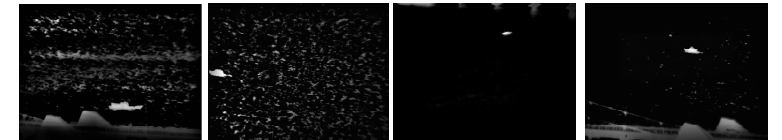
Gaussian Difference Image Local Minimum Image Figure 6. Flowchart of preprocessing algorithm to improve target saliency. First of all, according to the gray-level feature analysis results, the target is at the lowest gray level. Secondly, according to the results of the frequency domain feature anal- ysis of the image, it is possible to highlight the saliency of the target by filtering out the highest and lowest frequency information, and a Gaussian difference filter is constructed. Finally, the local minimum image and the Gaussian difference filtering result image are multiplied by Equation (4) to generate the required preprocessed image that can improve